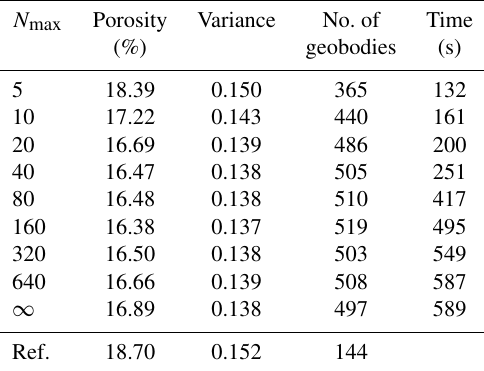
Table 2. Comparison of the performance for 20 realizations with three sections in each direction, varying the maximum of matched patterns from each training image N max . Other parameters are fixed and are the same as those in the test in Fig. 5. All the statistical values are the mean of 20 realizations. ∞ represents no constraint for N max